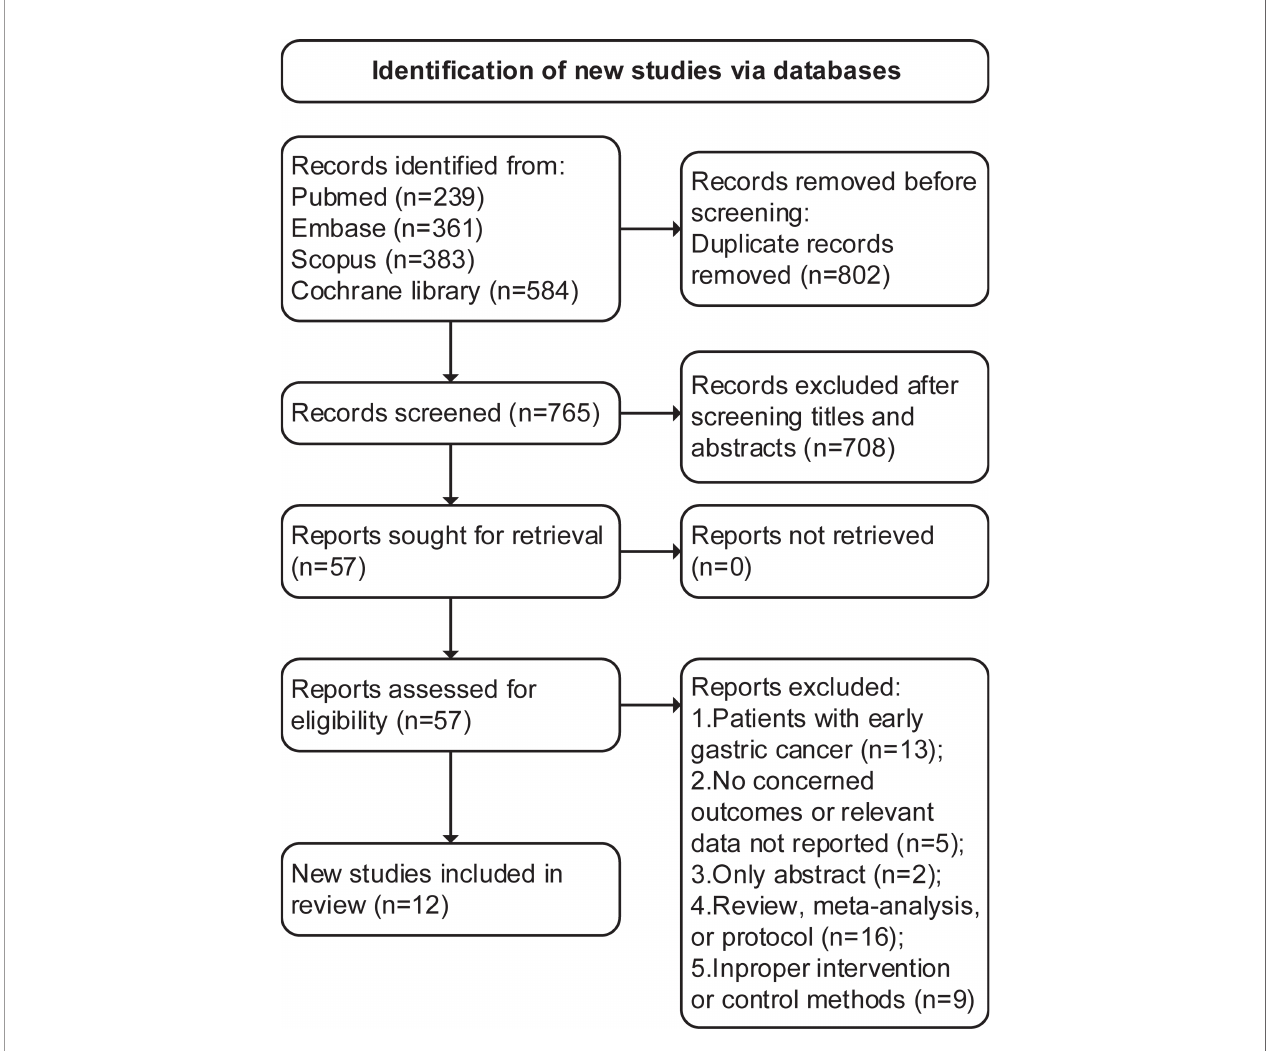
FIGURE 1 | PRISMA 2020 fl ow diagram for the